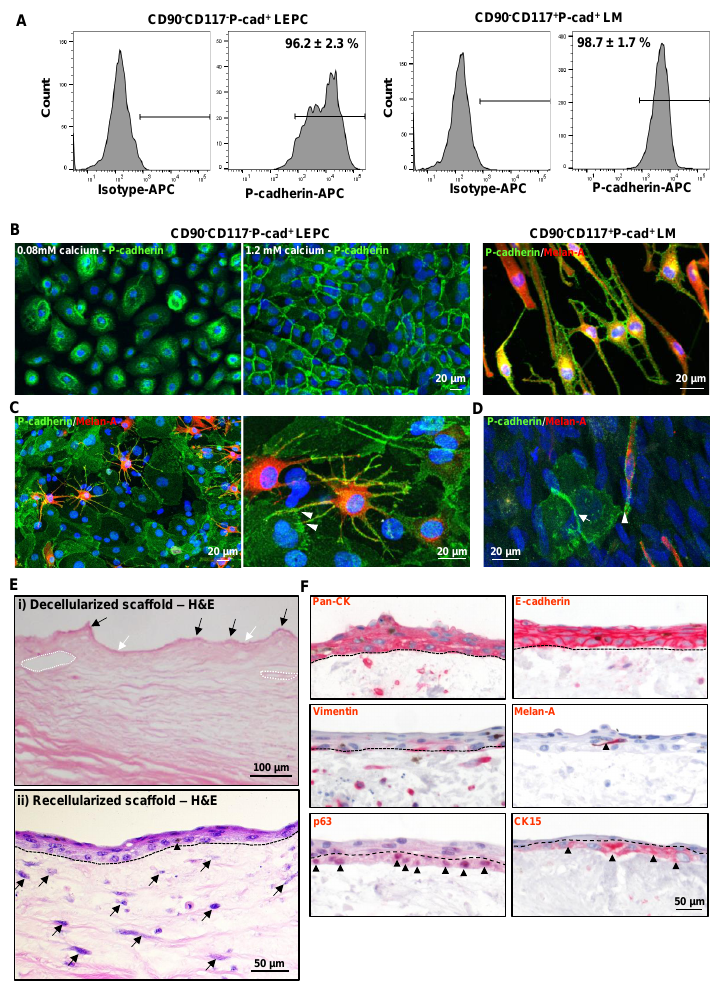
Figure 5. Association of P-cadherin in limbal cells and recellularization of scaffolds: ( A ) Flow cytometric analysis of cultured CD90 − CD117 − P-cad + and CD90 − CD117 − P-cad − cells showing expression of P-cadherin. Data are expressed as means ± standard error of the mean of 4 individual experiments. ( B ) Immunstaining analysis of cultured epithelial cells showing membranous staining of P-cad in CD90 − CD117 − P-cad + cells cultured in 0.08 mM Ca 2+ and its enrichment at cell–cell junctions in 1.2 mM Ca 2+ . Double immunostaining of CD90 − CD117 + P-cad + LM showing the co-localization of Melan-A and P-cad. Nuclear counterstaining with 4 (cid:48) ,6-diamidino-2-phenylindole (DAPI, blue). C&D Double immunostaining of cultured cluster cells. ( C ) and in vitro co-cultures of CD90 − CD117 − P- cad + LEPC and CD90 − CD117 + P-cad + LM. ( D ) showing expression of P-cad in both LEPC and LM and signal enhancement at the sides of cell–cell overlap (arrowheads showing overlaps of LEPC and LM, arrows showing the overlap of epithelial cells) Nuclear counterstaining with DAPI (blue). ( E ) Hematoxylin and Eosin (HE) staining of decellularized scaffold (i) showing a regular arrangement of collagen fibrils, connective tissue protrusions (black arrows), invaginations (white arrows), and vascular gaps (dashed circles) in the ECM. After seeding of both LEPC and LM on DHL scaffolds and three weeks of cultivation, recellularized scaffolds (ii) showing the stratification (2–3 layers) of the epithelium, and darkly pigmented cells (arrowhead, supposed to be melanocytes) interspersed between the epithelial cells. The scaffolds also showing the repopulation of limbal stroma (arrows). ( F ) Immunohistochemical staining of recellularized limbal scaffolds showing pronounced epithelial keratins (pan-cytokeratin (pan-CK)) expression and intercellular E-cadherin in all epithelial layers; vimentin staining in basal layers and also in the limbal stroma; Melan-A + melanocytes interspersed in the epithelial layers (arrowhead) (dashed line represents basement membrane); CK15, and p63 staining (arrowheads) in the basal layer (dashed line separates basal and suprabasal